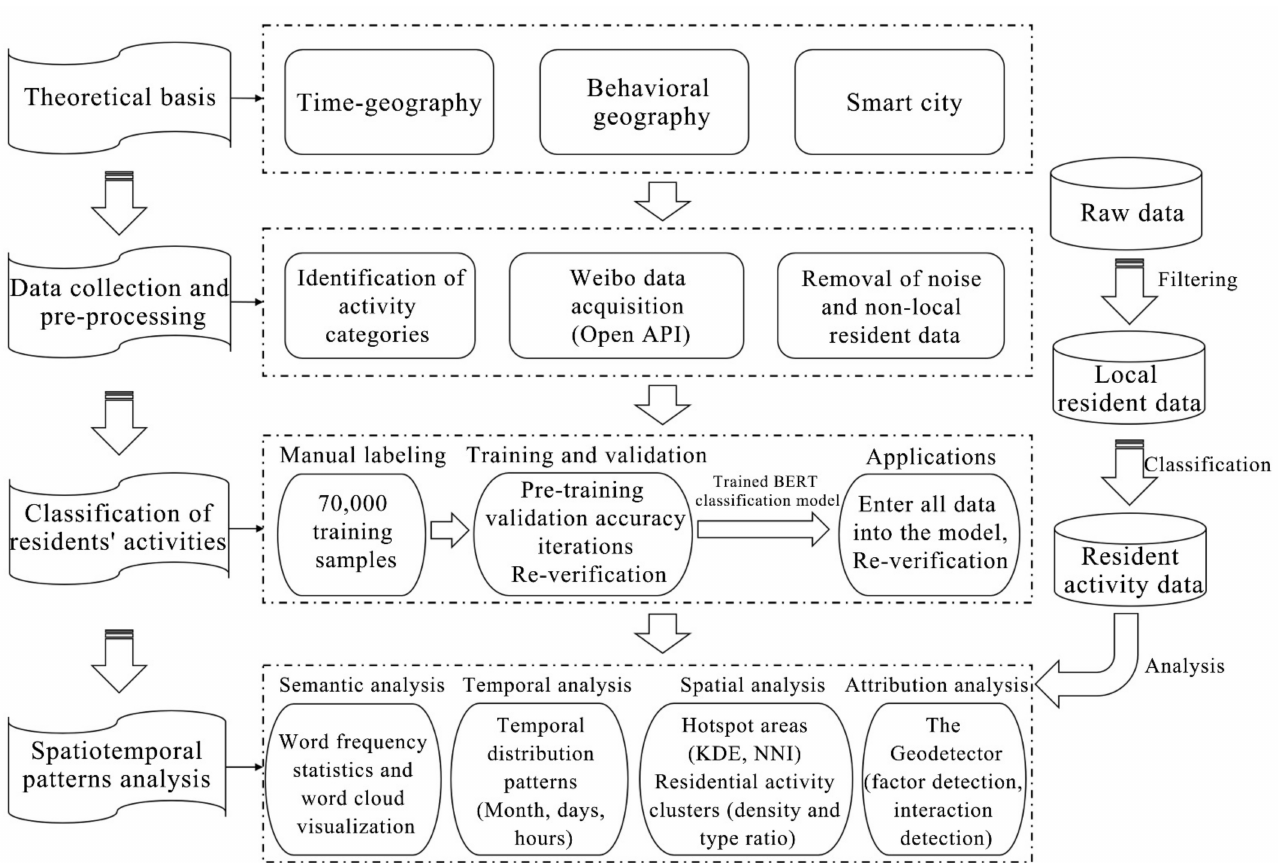
Figure 1. Framework of residents’ activities research based on social media